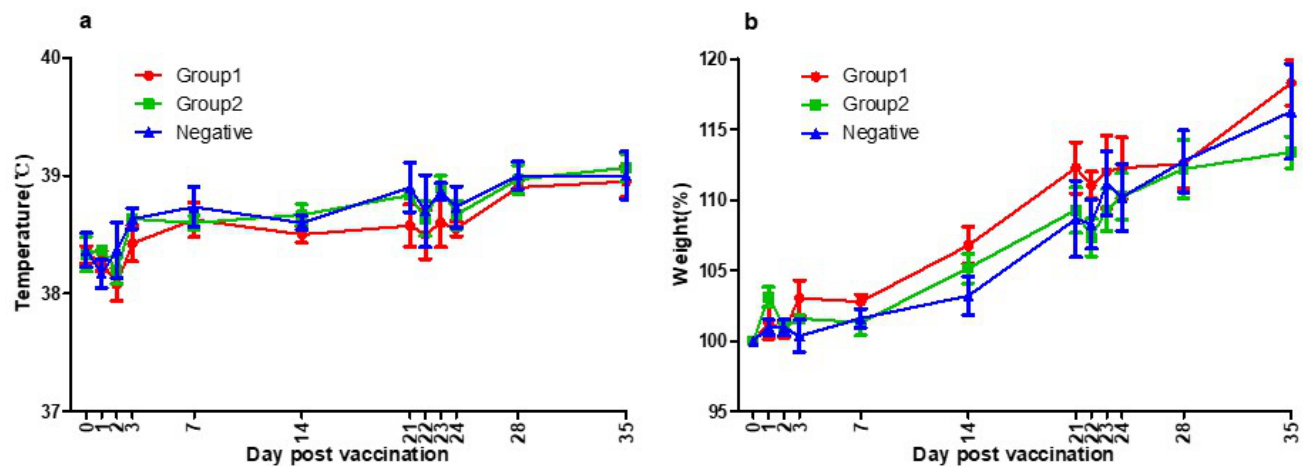
Figure 3. ( a ) Three groups’ temperatures of the day post-vaccination. Group1 (●), Group2 ( ■ ), and Negative Group ( ▲ ) showed the same patterns of body temperature. They were all within the normal range. As a result of temperature measurements, there was no side effect of the vaccines. ( b ) Three groups’ body weights of the day post-vaccination. Group1 (●), Group2 ( ■ ), and Negative Group ( ▲ ) showed the same patterns of growth rate. They were all within the normal range. As a result of bodyweight measurements, there was no side effect of the vaccines.